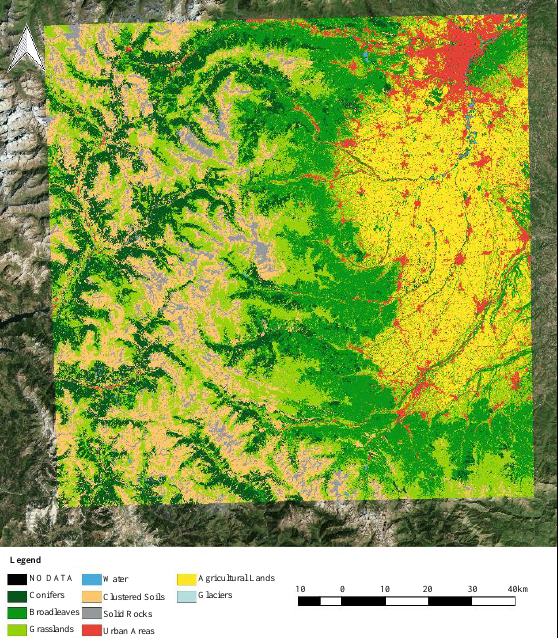
Figure 2. Classification of tile Q.